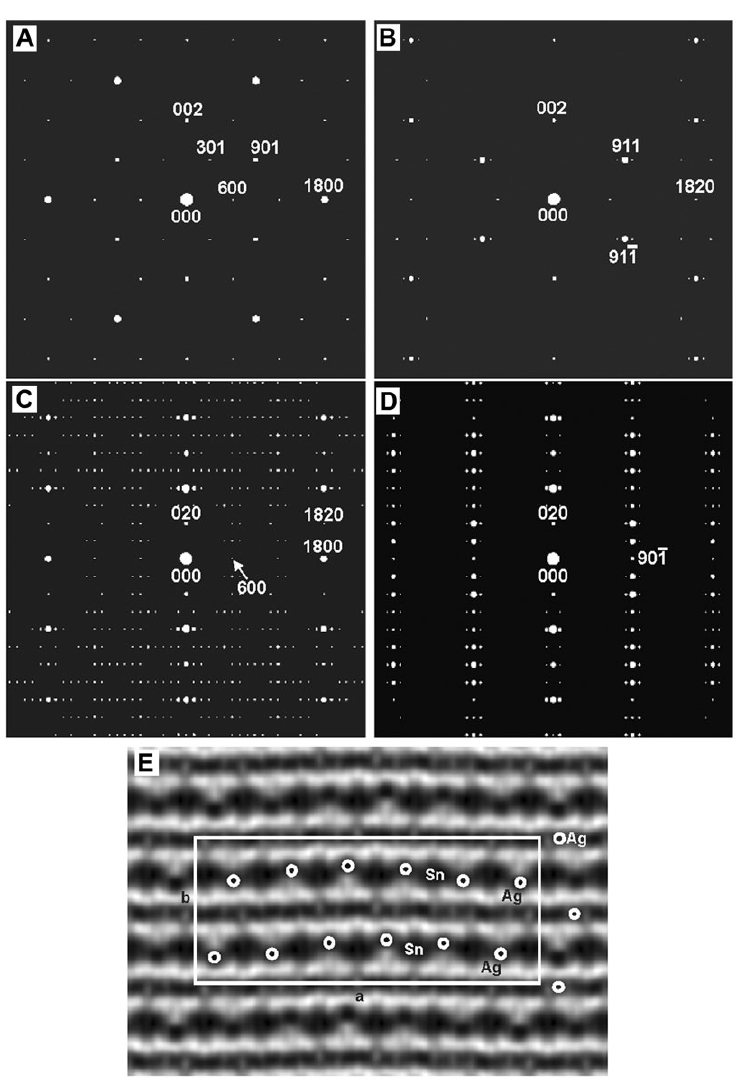
based on the proposed structure model. (E) Simulated HREM image along [001] based on the proposed structure model of Figure